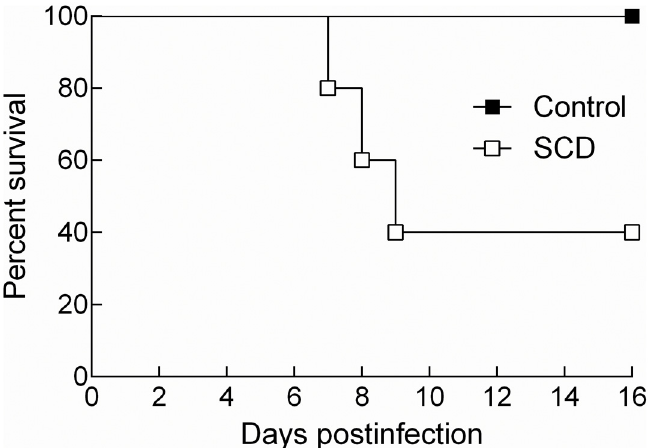
Fig 6. Prevnar-13 vaccination does not protect SCD mice from pneumococcal infection. Mice were vaccinated and challenged according to the schedule outlined in Fig 1. Mice were intranasally challenged with 1X10 6 CFU of A66.1 and mortality was assessed measured. p = 0.01, as determined by the log-rank/ Mantel-Cox test. White boxes = SCD, black boxes =